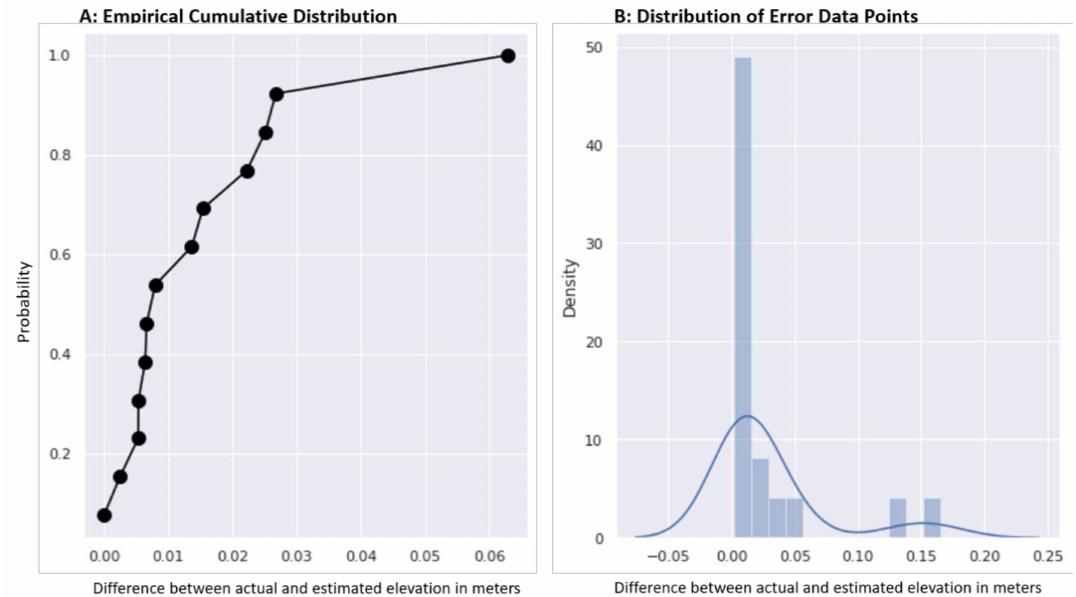
Figure 11. ( A ) Empirical Cumulative Distribution of the error; ( B ) Distribution of the resultant